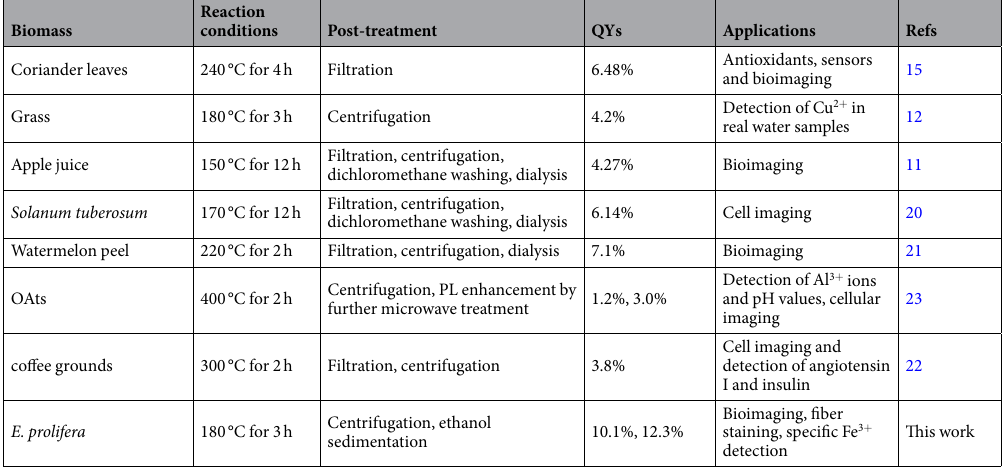
Table 1. Comparison of QYs and applications among varied CNDs from different biomass as carbon sources prepared by hydrothermal treatment at different conditions and post-treatment